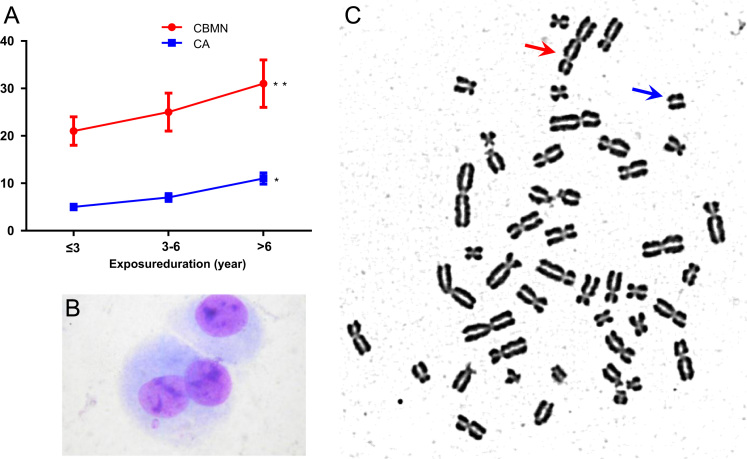
Relationship between exposure duration and frequency of CA and CBMN in lymphocytes of exposed subjects. A: It shows significant relationships between CA, CBMN and exposure duration in lymphocytes. B: One micronucleus in a binucleated lymphocyte of the group of workers recycling e-wastes. C: A metaphase lymphocyte of the group of workers recycling e-wastes. The red arrow directs a dicentric chromosome; the blue arrow directs an acentric fragment. **: P < 0.01, *: P < 0.05.